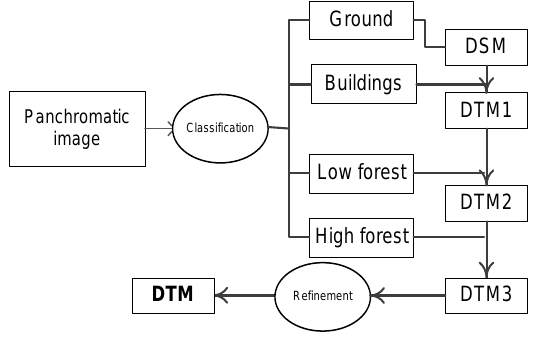
Figure 1. Flow chart of the proposed method